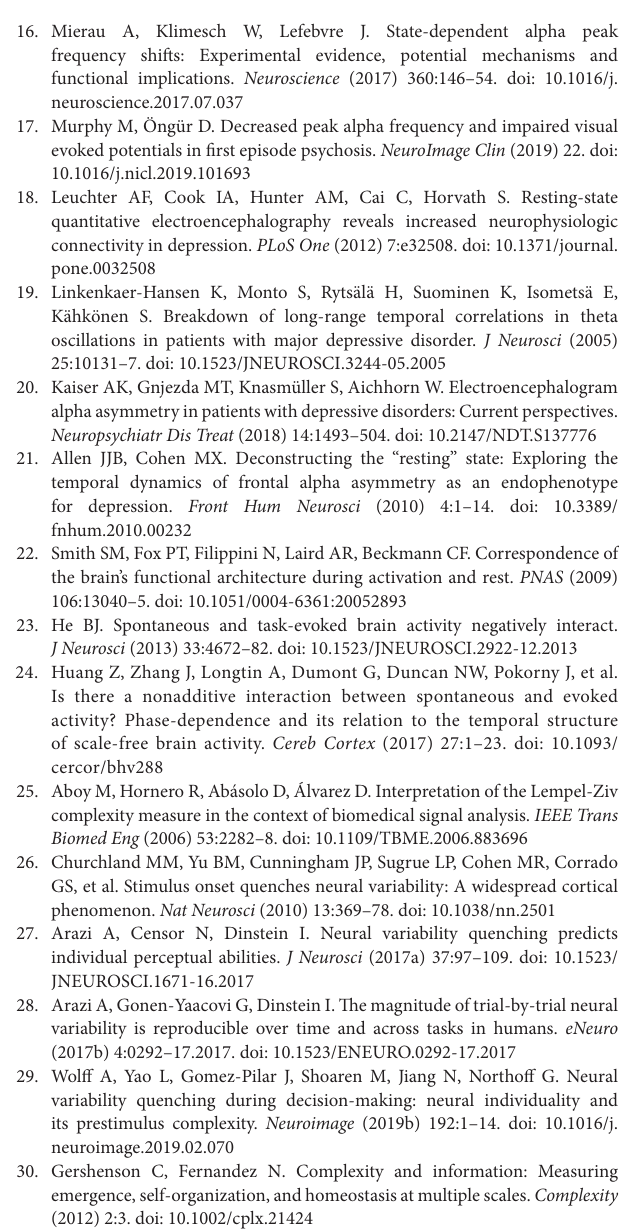
SUPPLEMENTARY FIGURE 1 | Frequency Sliding (FS) and Power Sliding (PS) between groups for both stimuli in absolute values, not relative change. (A) Theta for deviant stimuli. (B) Theta for standard stimuli. (C) Alpha for deviant stimuli. (D) Alpha for standard stimuli. *: < 0.05, **: < 0.01, ***: